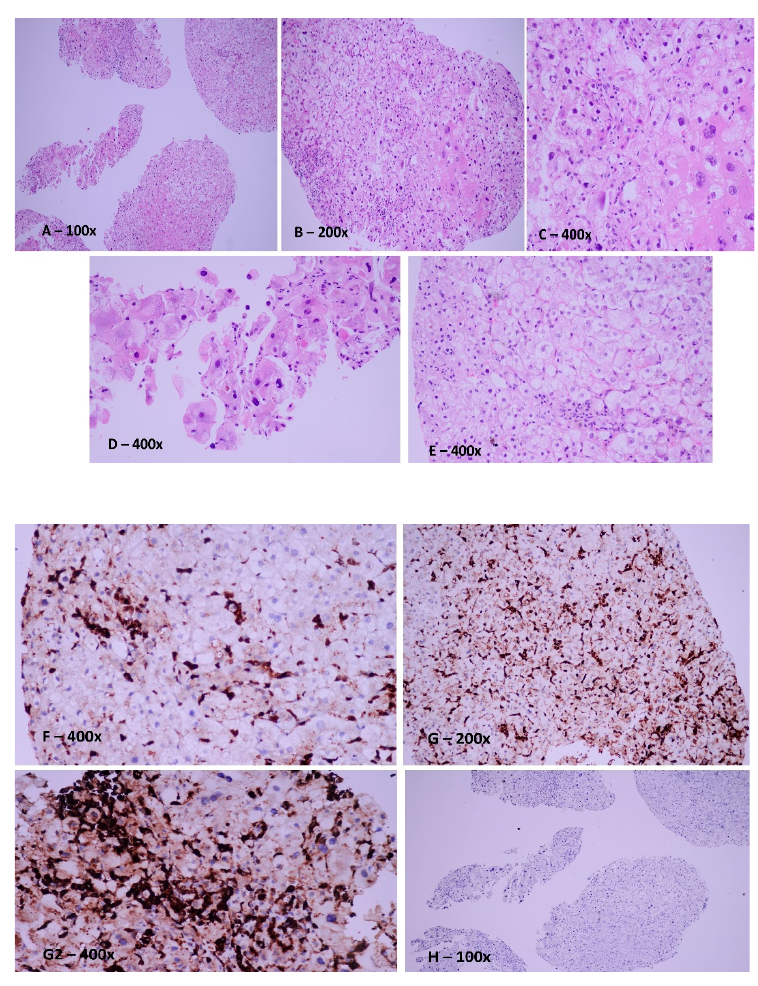
Figure 3. Transjugular liver biopsy–usual Hematoxylin-Eosin staining (Figures ( A – E , H )). Dissociated cylindrical biopsy fragments are represented by hepatic parenchyma (image ( A )) with preserved architecture but with regenerative changes of hepatocytes (image ( B )) and focal necroinflammatory lobular activity (image ( C )). There are hyperplastic Kupffer cells in the sinusoidal spaces that are positive in immunohistochemical staining for CD 68 (image ( G , G2 )) and negative in an immunoassay for CD 1a. Phagocytosis, intracytoplasmic erythrocytes (image ( D )), but also lymphocytes (image ( E )), better identifiable in immunohistochemical staining for CD 68 (image ( F )), were found in isolation.